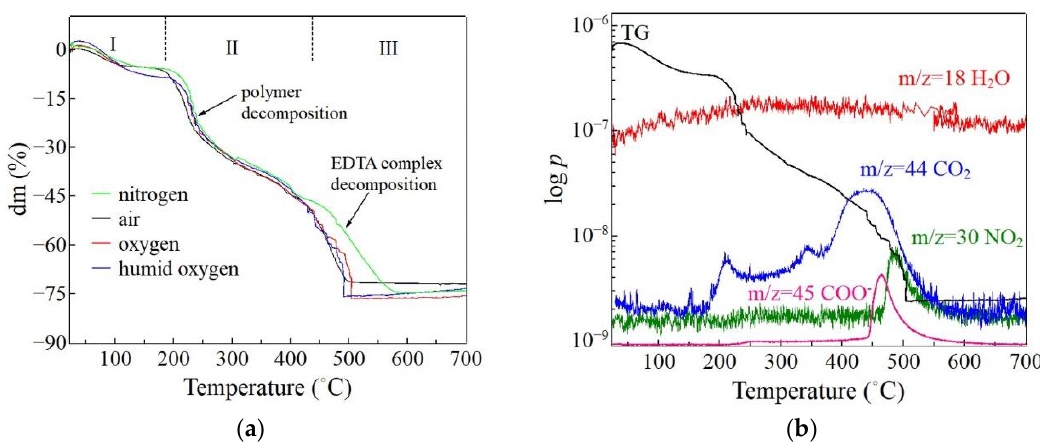
Figure 2. ( a ) TG curves in oxidative and inert atmosphere; ( b ) MS curves of the precursor powder heated at a rate of 5 °C/min (TG curve was added for reference).